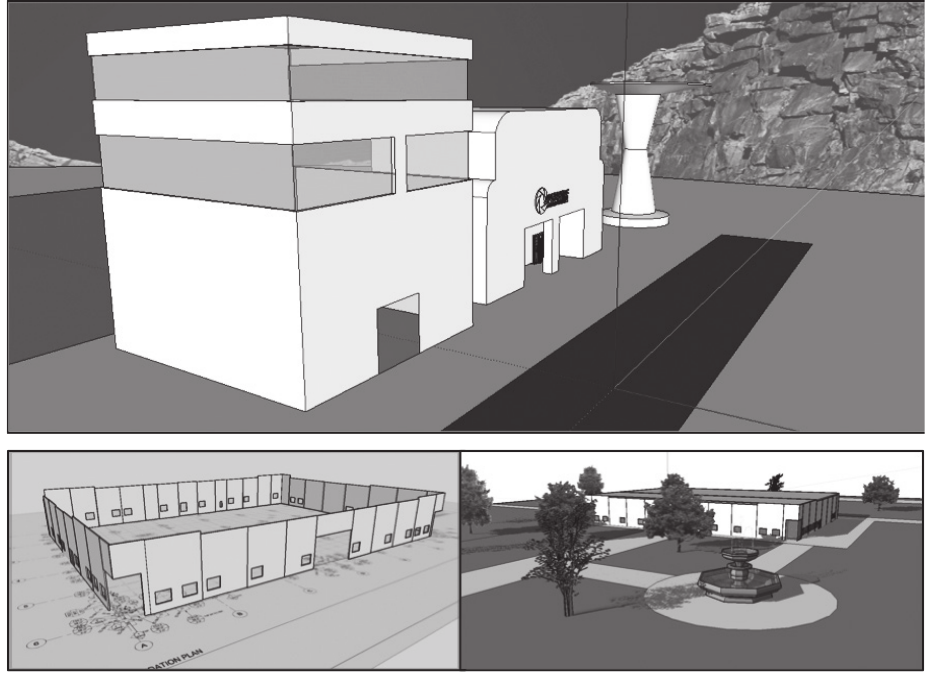
Figure 1: Three-dimensional design created by a student,